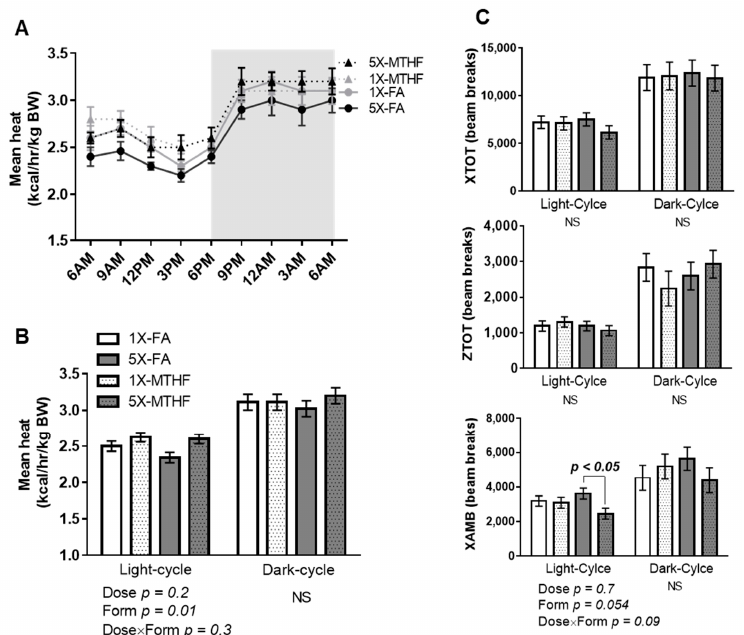
Figure 3. Mean ( A ) 24-h and ( B ) 12-h energy expenditure (kcal/h/kg body weight, BW) calculated as heat production of female offspring at 15 weeks post-weaning. ( C ) Total locomotor (XTOT), ambulatory (XAMB) and stereotypy (ZTOT) activity calculated as beam breaks every 12 h. Values are least square Mean ± standard error of the mean (S.E.M), n = 8/group. Twelve-hour energy expenditure and activity analyzed by two-way ANOVA with Dose (1X or 5X) and Form (FA vs. MTHF) as main factors and a Dose×Form interaction term. Significant at p < 0.05. Values in bold indicate significant effects. Abbreviations: AIN-93G rodent diet with either 1X-FA, recommended folic acid (2 mg/kg diet); 5X-FA (10 mg/kg diet); 1X-MTHF, equimolar recommended [6S]-5-methyltetrahydrofolic acid calcium salt (2.1 mg/kg diet); or 5X-MTHF (10.4 mg/kg diet); NS, non-significant; BW, body weight.